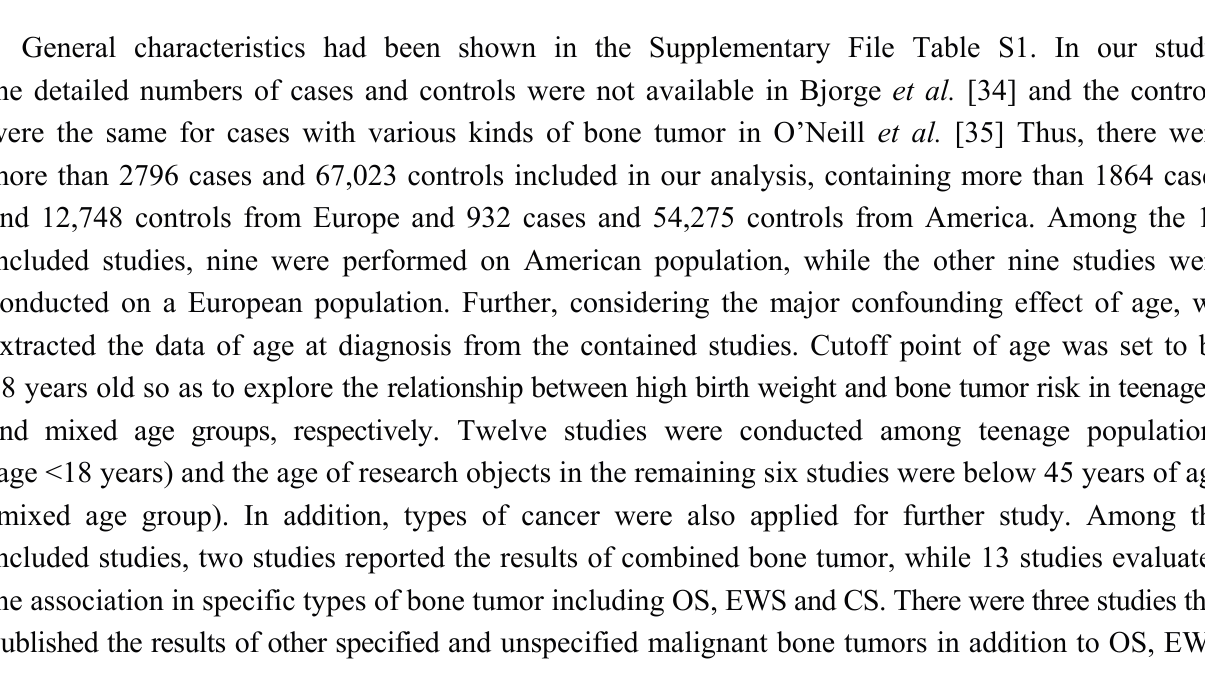
Figure 1. Flow chart of the identification and screening